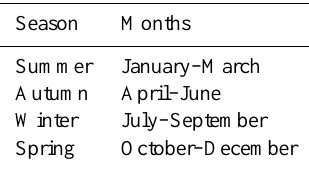
Table 1. The allocation of months to